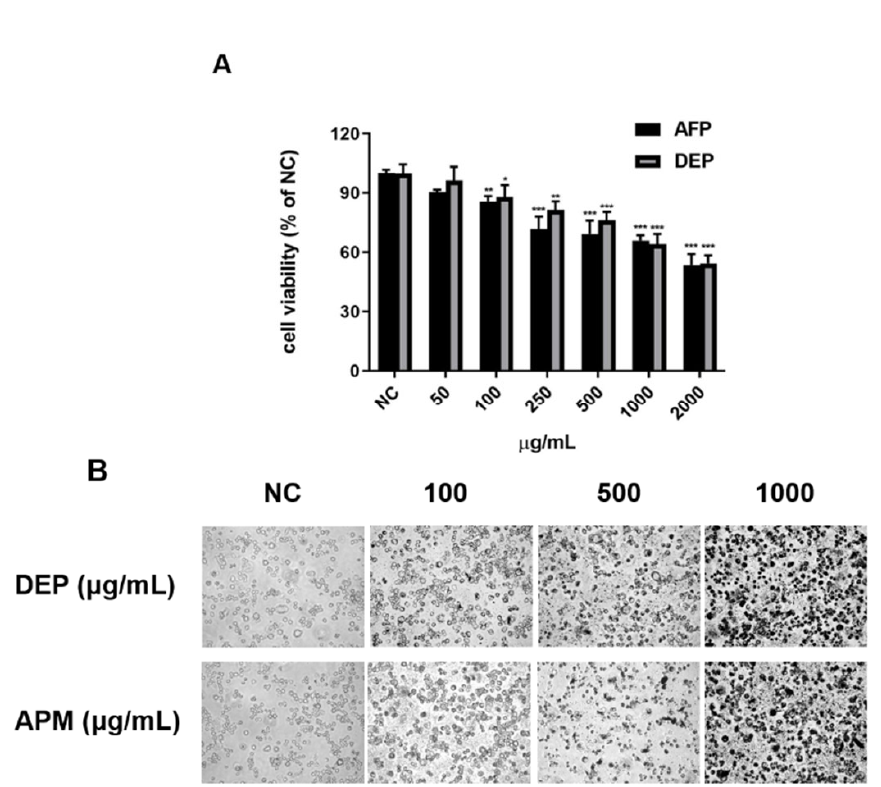
Figure 1. Cytotoxicity of artificial particulate matter (APM) and diesel exhaust particles (DEP) in alveolar macrophages (MH ‐ S). Negative controls (NC) are untreated samples. MH ‐ S was treated with APM and DEP of different concentrations for 6 h. ( A ) Cell viability was measured using the 3 ‐ (4,5 ‐ Dimethylthiazol ‐ 2 ‐ yl) ‐ 2,5 ‐ Diphenyltetrazolium Bromide (MTT) assay in the APM ‐ and DEP ‐ stimulated MH ‐ S cells. ( B ) Morphological changes in MH ‐ S by exposure to APM/DEP. Data are presented as the mean ± SD (n = 6 per group). * p < 0.05, ** p < 0.01, or *** p < 0.001 vs. NC.